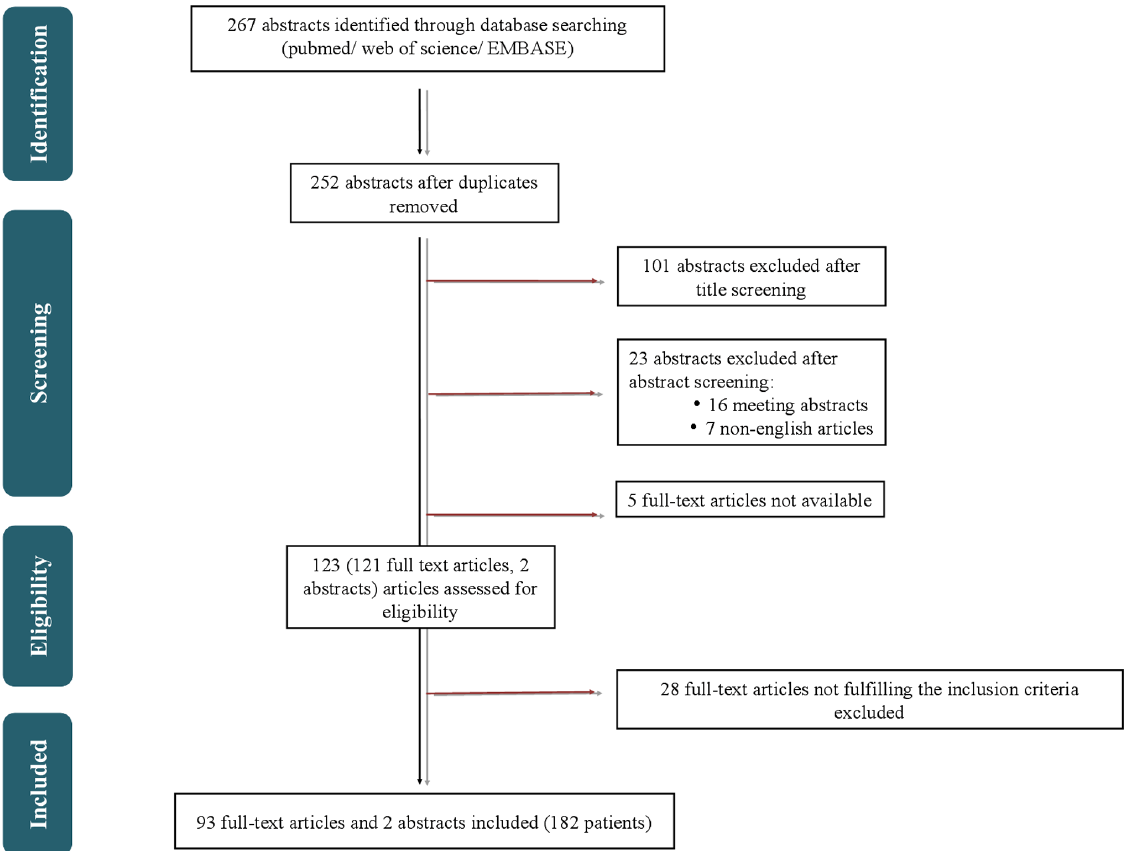
Figure 1. Systematic literature search. Procedure of publication retrieval and in- and exclusion of cases is displayed in a PRISMA (preferred reporting items for systematic reviews and meta-analyses) flow chart.